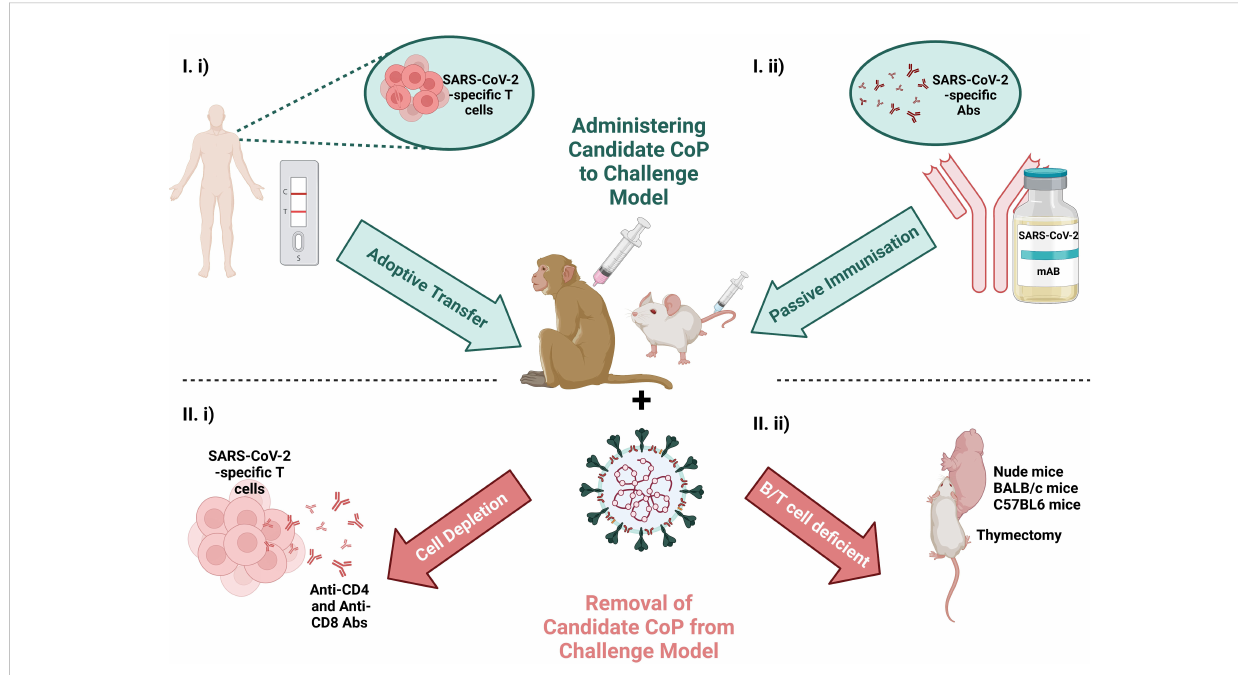
FIGURE 4 Schematic of the scope to manipulate the immunological response by I) administering the candidate CoP to the challenge model (at top in blue) via i) adoptive transfer of T cells from a convalescent individual or ii) passive immunisation with convalescent serum or a therapeutic mAb or II), removing candidate CoP from challenge model (at bottom in red) via i) T cell depletion or ii) use of an immunode fi cient animal model. Challenging the animal with virus and ascertaining the effects of removal/addition of these immune features on virology and pathology, can provide evidence for/against the candidate CoPs. Created with